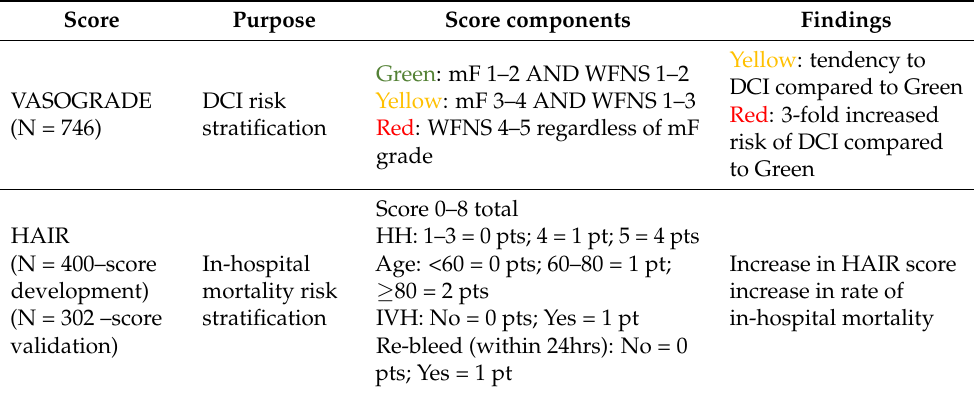
Table 4. VASOGRADE and HAIR scores, from respective studies, for aneurysmal subarachnoid hemorrhage. Modified Fisher scale (mF), World Federation of Neurosurgical Societies scale (WFNS); Hunt and Hess score (HH); Intraventricular hemorrhage (IVH). Score Purpose Score components